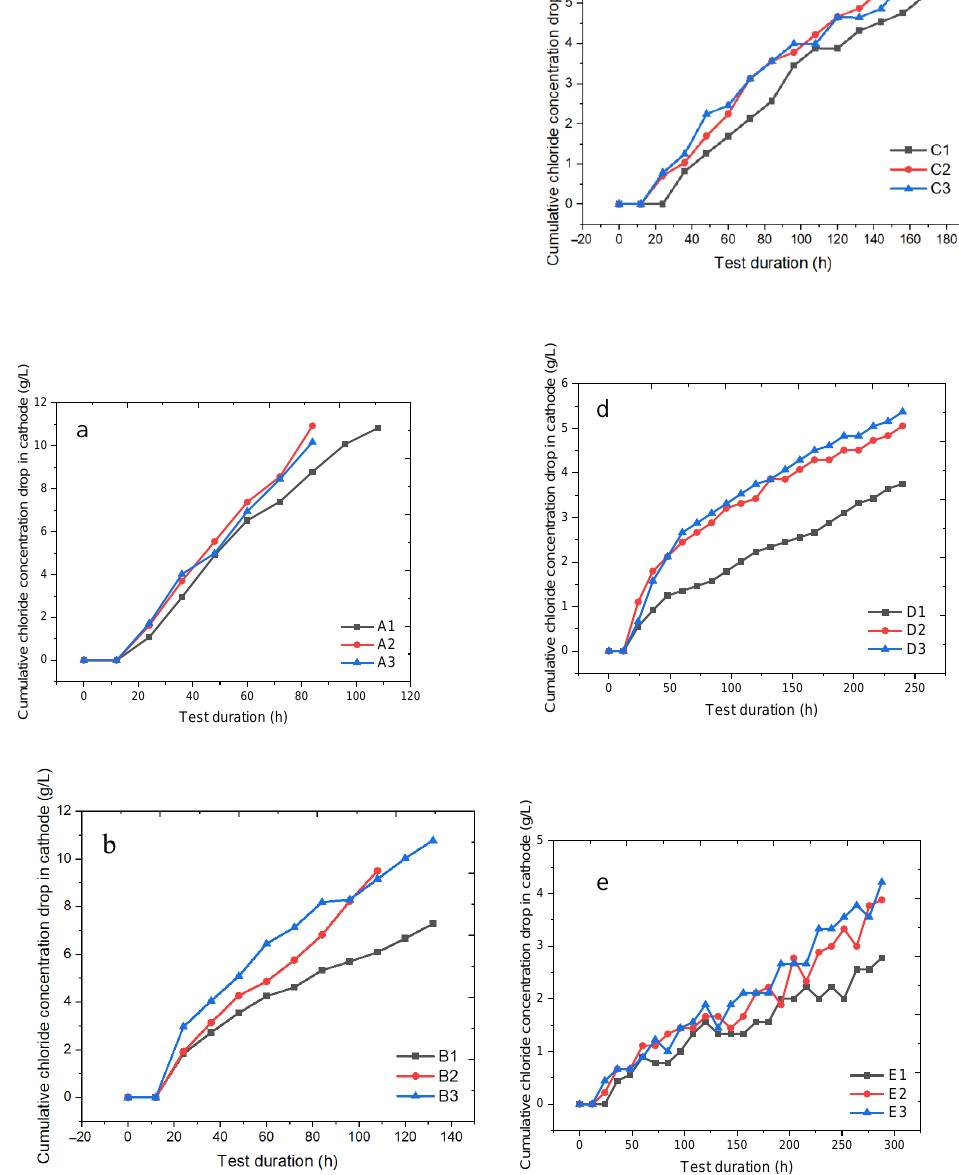
Figure 6. Cumulative chloride concentration drop in cathode cell: ( a ) w/c = 0.55 cement mortar samples, ( b ) w/c = 0.50 cement mortar samples, ( c ) w/c = 0.45 cement mortar samples, ( d ) w/c = 0.40 cement mortar samples, ( e ) w/c = 0.35 cement mortar samples.